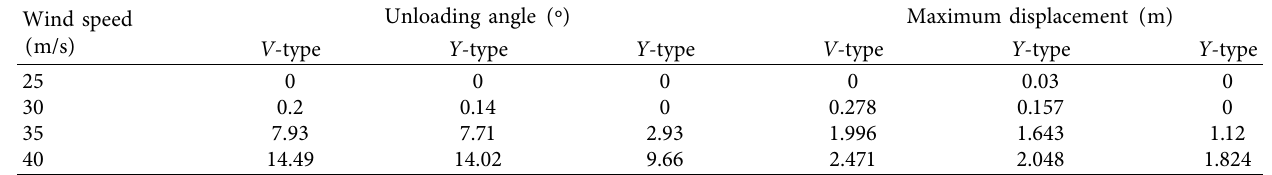
Table 7: Te comparison of analysis results between the no. 3 and no. 4 insulator strings.